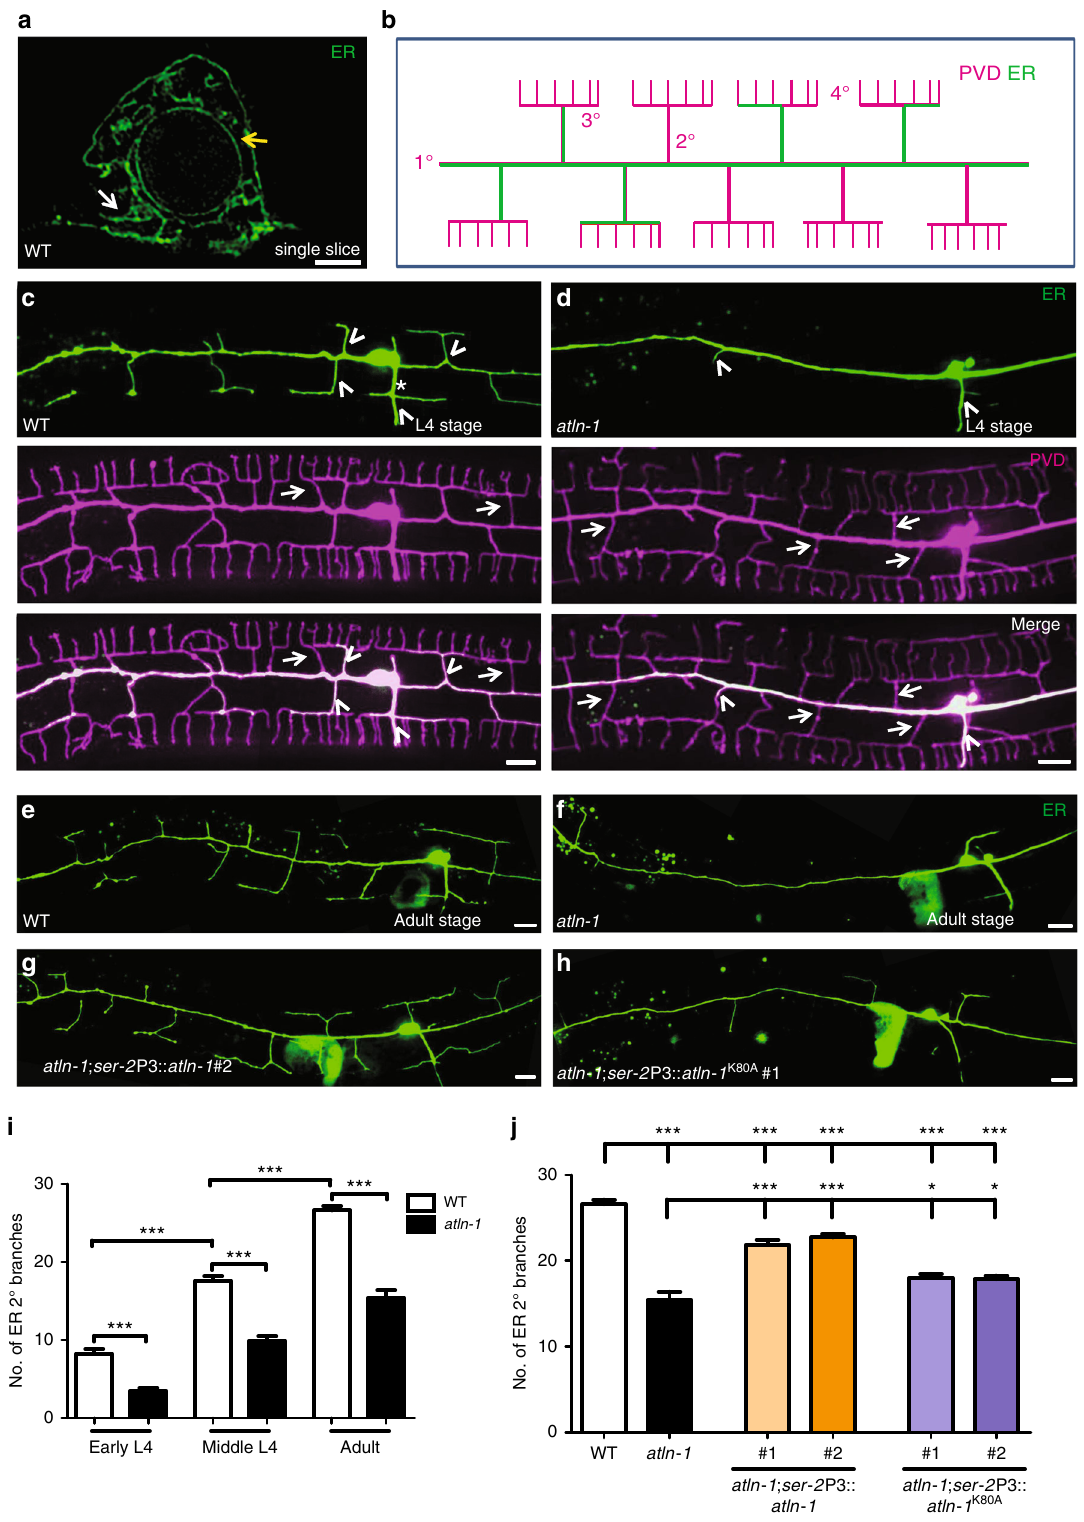
Fig. 1 ATLN-1 is required for ER invasion into dendrites. a A representative 3D-SIM image of ER (GFP::SP12) in wild-type PVD soma (A single focal plane is shown). The yellow arrow indicates the nuclear membrane and the white arrow indicates a tubular network. Scale bar, 1 μ m. b A schematic picture showing that ER extends into some but not all 2° and 3°dendrites in PVD. Magenta lines represent PVD dendritic branches and green lines indicate ER distribution. c , d Representative confocal images of ER (GFP::SP12) and dendritic morphology of PVD neuron ( ser-2 P3::mCherry) in wild type ( c ) and atln-1 ( wy50080 ) mutant ( d ) at L4 stage. Arrows show PVD 2° branches without ER and arrowheads indicate PVD 2° branches with ER. Asterisks mark the PVD axon. Scale bars, 10 μ m. e – h Representative ER morphology of PVD neuron in WT ( e ), atln-1 ( f ) , atln-1; ser-2 Prom3:: atln-1 #2 (transgenic line #2) ( g ) and atln-1; ser- 2 Prom3:: atln-1 K80A #1(transgenic line #1) ( h ) at adult stage. Scale bars, 10 μ m. i , j Quanti fi cation of ER 2° branches number. Values are mean and error bars are SEM, n = 46 for each genotype. * p < 0.05; *** p < 0.001 (two-sided student ’ s t test and Tukey ’ s multiple comparison